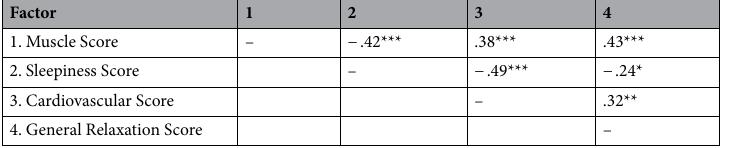
Table 3. Factor correlations for the four factors. Factor correlations derived from EFA. All correlations reached significance. * p < .05. ** p < .01. *** p < .001.